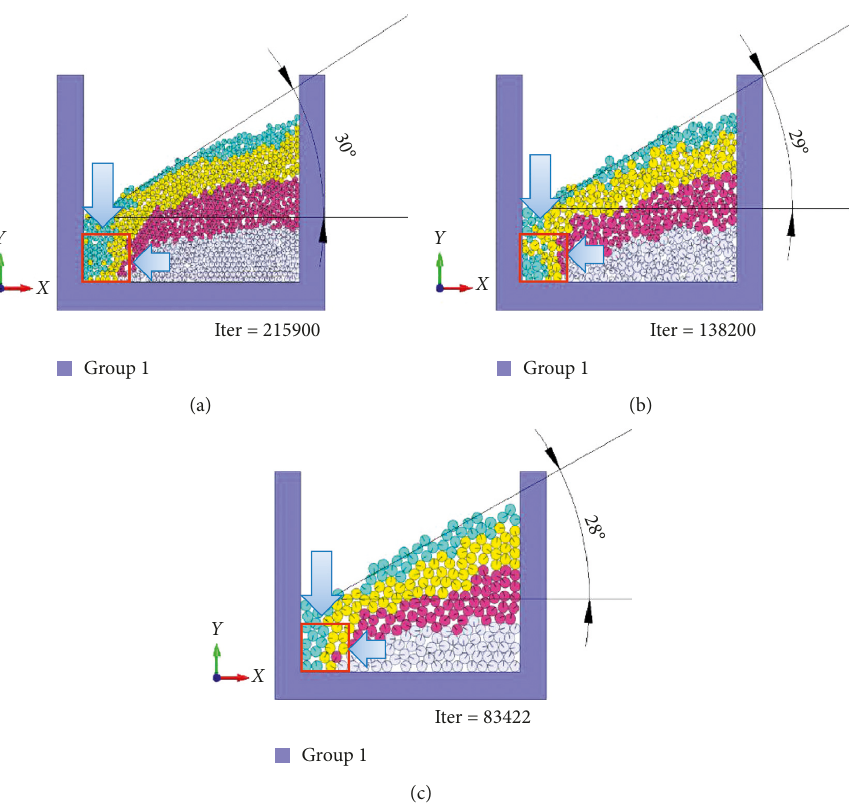
Figure 7: Collapsed process of excavation of the left lower part of coal particles with different particle sizes. (a) Coal particles of 0.1m particle size. (b) Coal particles of 0.1–0.2m particle size. (c) Coal particles of 0.2m particle size.